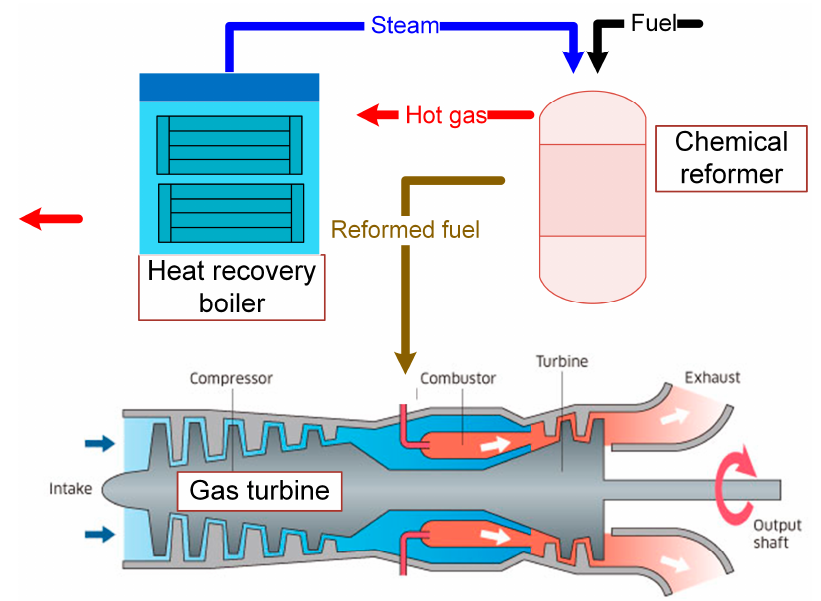
Figure 1. Schematic diagram of the selected gas turbine.